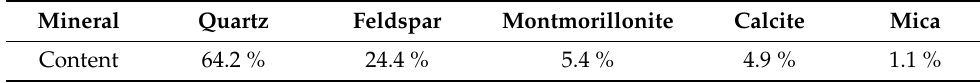
Table 1. Rock mineral composition.